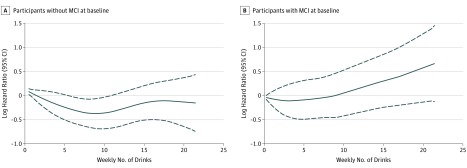
Risk of Dementia in Participants With and Without Mild Cognitive Impairment (MCI) at Baseline by Self-reported Weekly Number of DrinksPlots show log hazard ratios (solid lines) and 95% confidence intervals (dashed lines) for risk of dementia by self-reported weekly number of drinks among 2548 participants without MCI at baseline (A) and 473 participants with MCI at baseline (B). Log hazard ratios were obtained from a generalized additive proportional hazards model with 3 df adjusted for age, sex, race/ethnicity, clinic site, educational level, social activity, smoking status, body mass index, lipid-lowering medication use, history of cardiovascular disease, diabetes, Center for Epidemiologic Studies Depression Scale score, treatment group assignment, and APOE genotype.